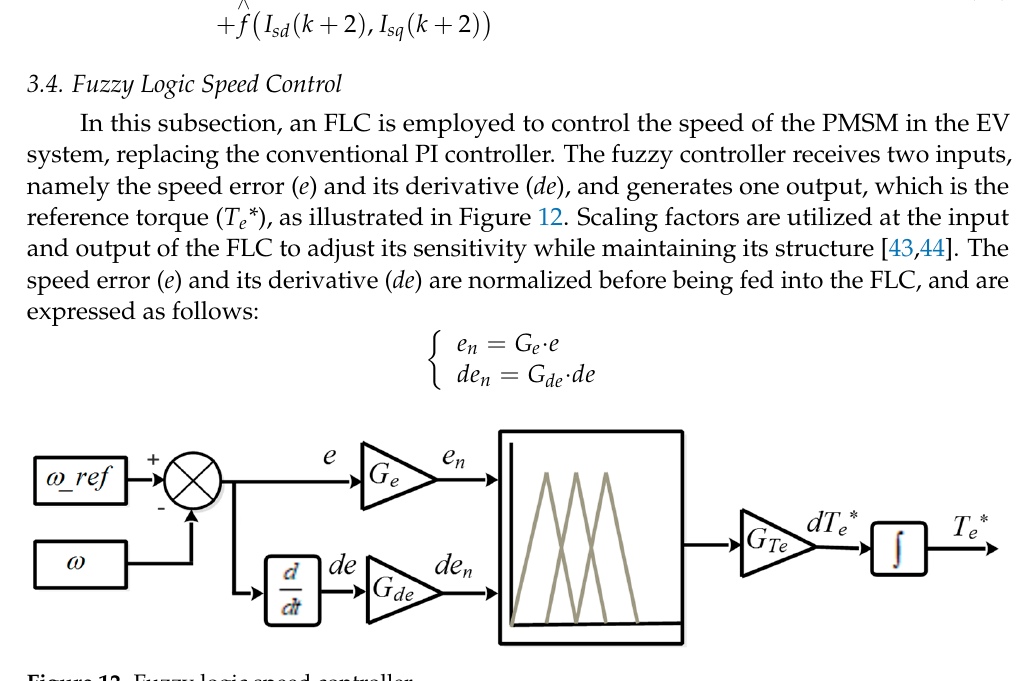
( c ) Figure 13. Membership functions for ( a ) speed error; ( b ) derivative speed error; ( c ) reference torque. Table 6 represents the fuzzy logic rules corresponding to the fuzzy speed controller. According to this table 49 fuzzy rules (7 × 7) are determined on the basis of two inputs, speed error and derivative speed error to select the appropriate reference torque. Mamdani’s inference procedure was used to perform the speed controller, and the center of gravity method was applied for defuzzi fi cation to calculate the proposed controller output. Table 6. Rule base for speed control. de